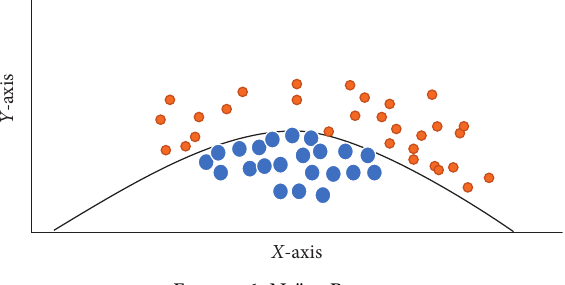
Figure 5: Random Forest.